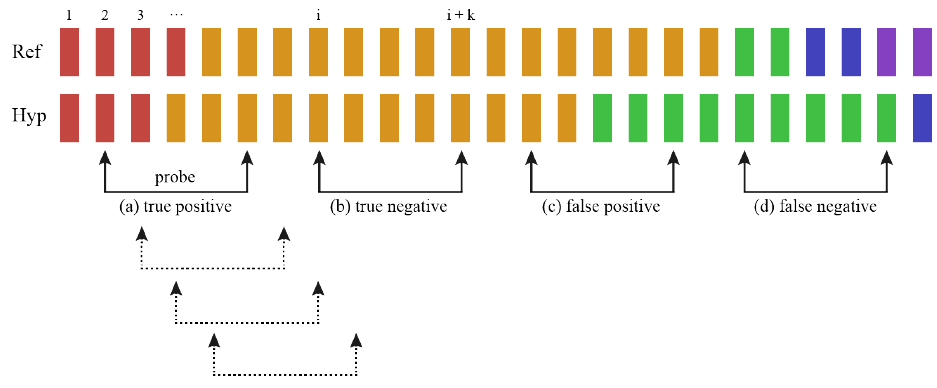
Figure 25. Exploration process of the probe of Pk , Wd . Colored squares represent each sentence. The leftmost square represents the first sentence of text, and the color of the square represents the topic. The U-shaped joined arrows represent the probe, which moves one sentence at a time from left to right, as shown by the dotted